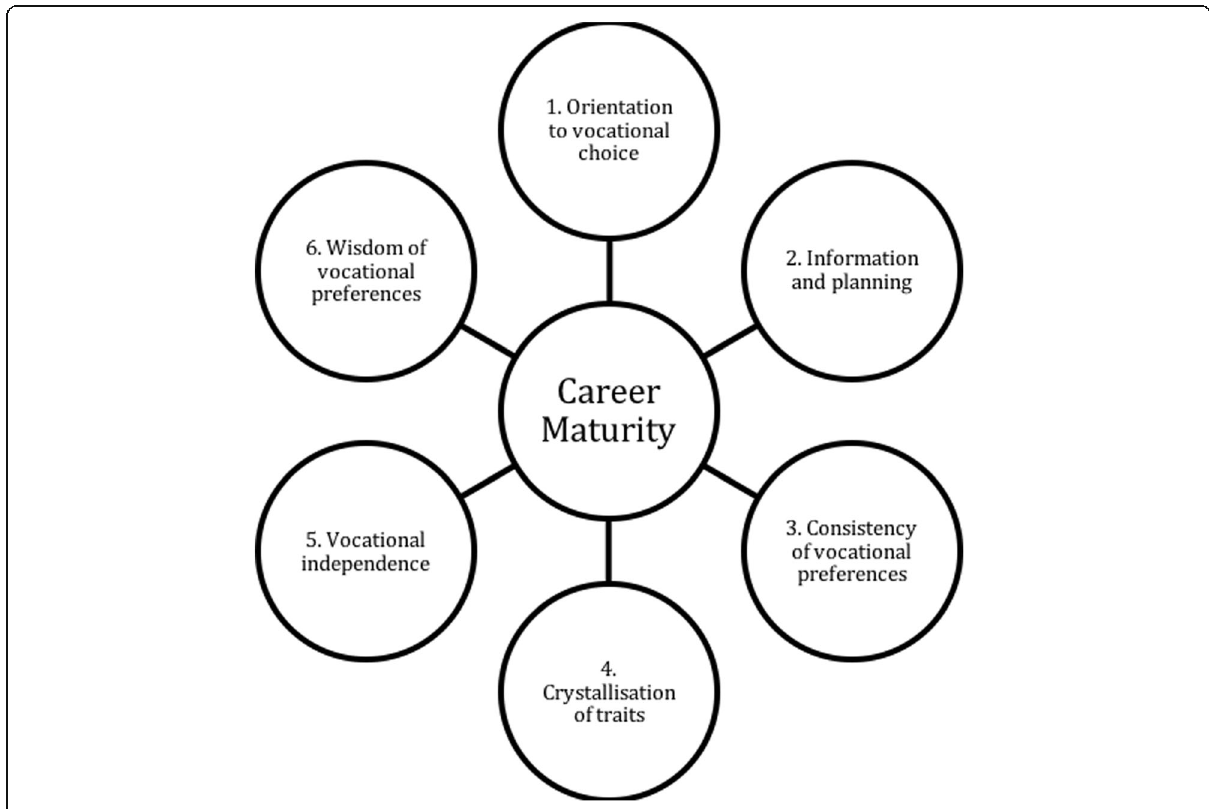
Fig. 1 Dimensions of career maturity (Super,